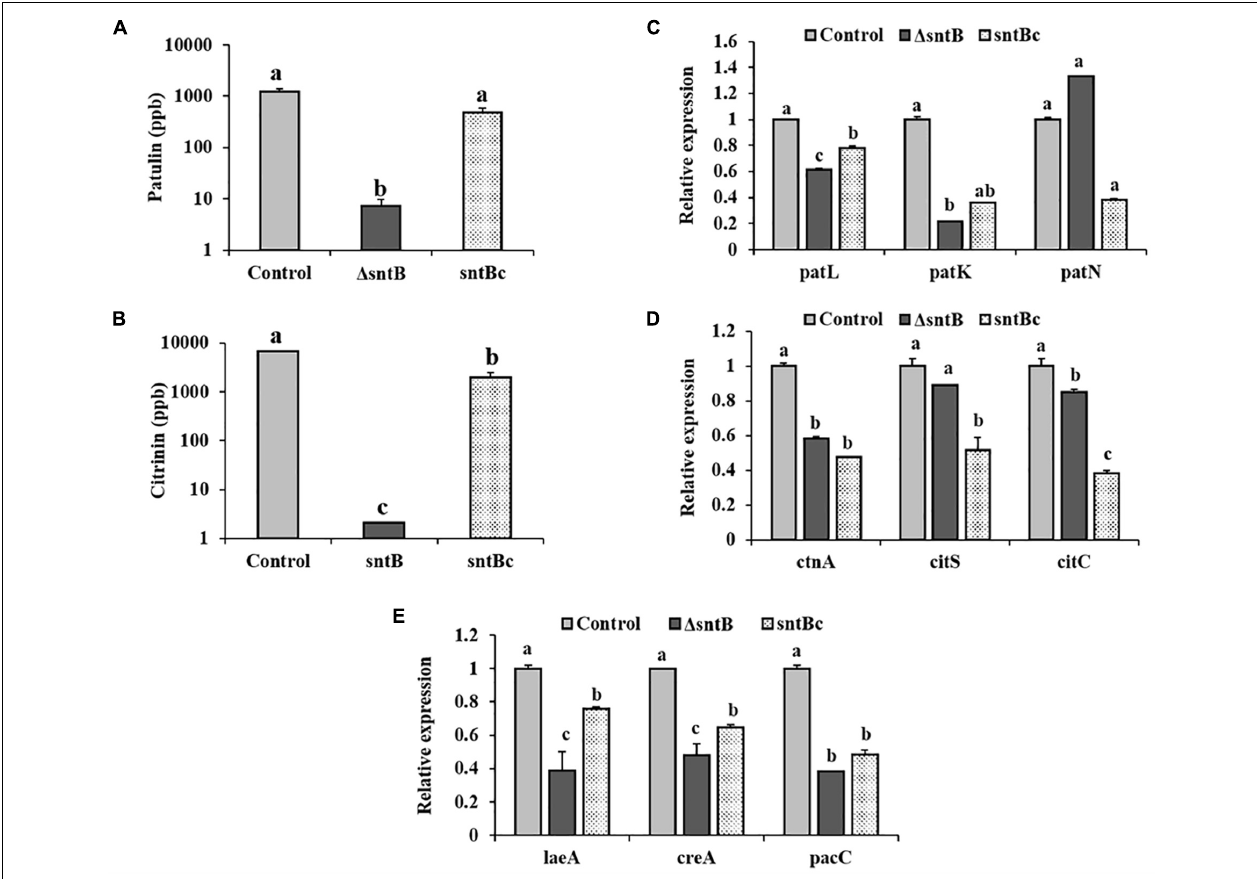
FIGURE 2 | SntB-associated regulation of patulin and citrinin biosynthesis. The three Penicillium strains (control, (cid:49) sntB , and sntB c) were grown on solidified YES media at 28 ◦ C. Patulin (A) and citrinin (B) levels, relative expressions of patulin (C) and citrinin cluster genes (D) , and global transcription factors (E) were evaluated at 4 days post-inoculation. Error bars represent the standard error of the mean (SEM) across three technical replicates. One-way ANOVA differences were considered significant when p < 0.05. Different letters above the columns indicate statistically significant differences between the strains as determined using Tukey’s single-step multiple comparison